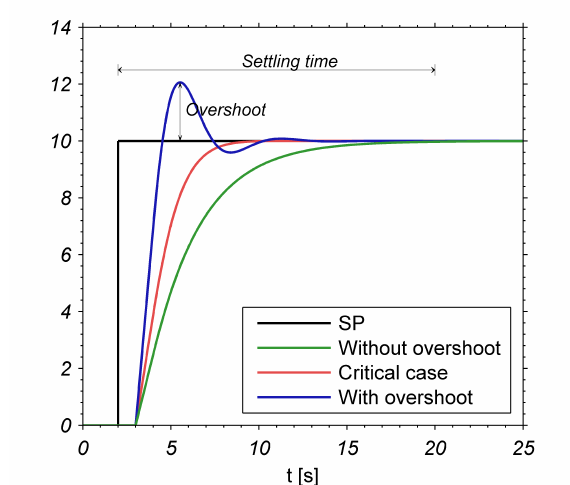
Figure 2: Possible responses of the control system to a step change in the SP for three various sets of the controller